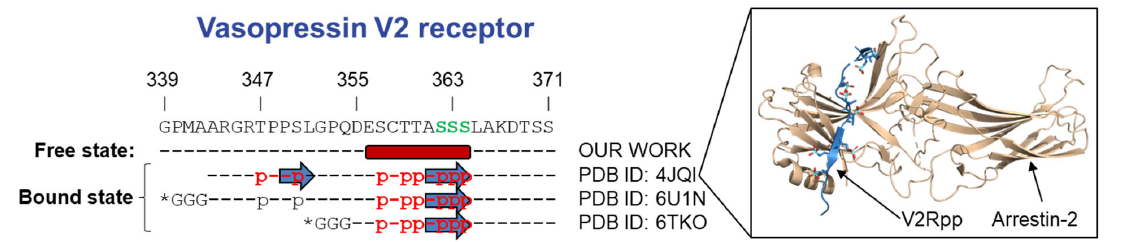
Figure 5. A conformational change must occur in the C ‐ terminal region of V2R (blue) upon binding to arrestin and/or phosphorylation . Comparison of the free, in solution state of V2R ‐ Cter to its bound state identified in complexes between a fully phosphorylated phospho ‐ peptide of vasopressin V2 C ‐ terminus (V2Rpp) and arrestin ‐ 2. On top is represented the sequence of human V2R C ‐ terminus. Residues known to be phosphorylated by GRKs are colored in green [73]. Below, V2R ‐ Cter sequences used in each work are represented in dashed lines. Residues encompassing the binding regions are identified in red and phosphorylated residues are noted as p. Stars (*) indicate that the V2R C ‐ terminus is fused to another receptor (PDB: 6U1N, muscarinic receptor; 6TKO: β 1 ‐ adrenergic receptor). Helices and β‐ strands are represented as red cylinders and blue arrows, respectively. In the frame, the PDB structure of V2R:arrestin ‐ 2 complexes is shown [21]. Phosphorylated residues of V2Rpp (in blue) are highlighted as sticks.